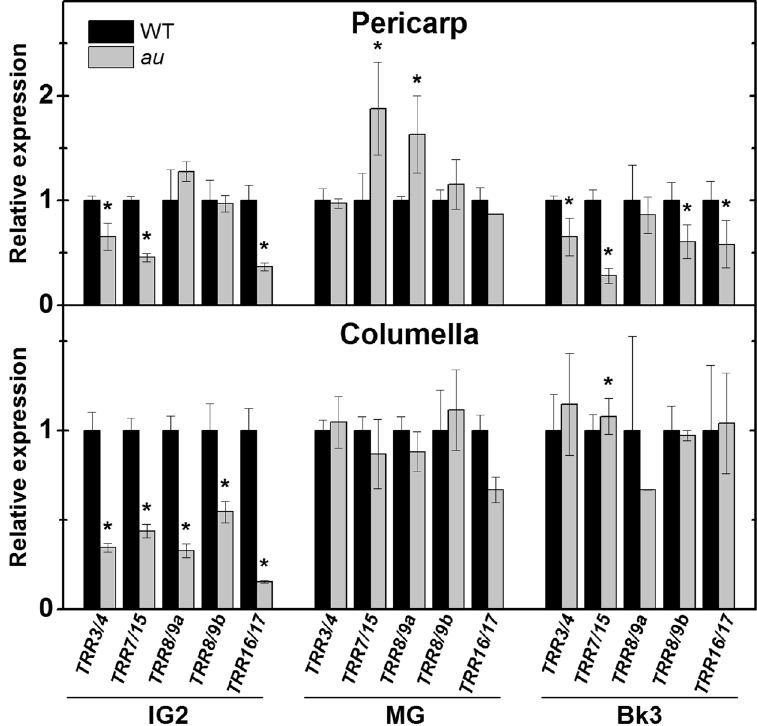
Figure 4. Deficiency in phytochromobilin downregulates primary cytokinin response genes during early tomato fruit development. Transcriptional profile of TOMATO RESPONSE REGULATOR ( TRR ) genes was performed in pericarp and columella tissues of immature (IG), mature green (MG) and ripening (Bk3, 3 days after breaker) fruits of wild-type (WT) and aurea ( au ) mutant plants. Transcript abundance was normalized against WT at each fruit developmental stage. Asterisks indicate statistically significant differences (Student’s t-test, P < 0.05) compared with the WT at each fruit development